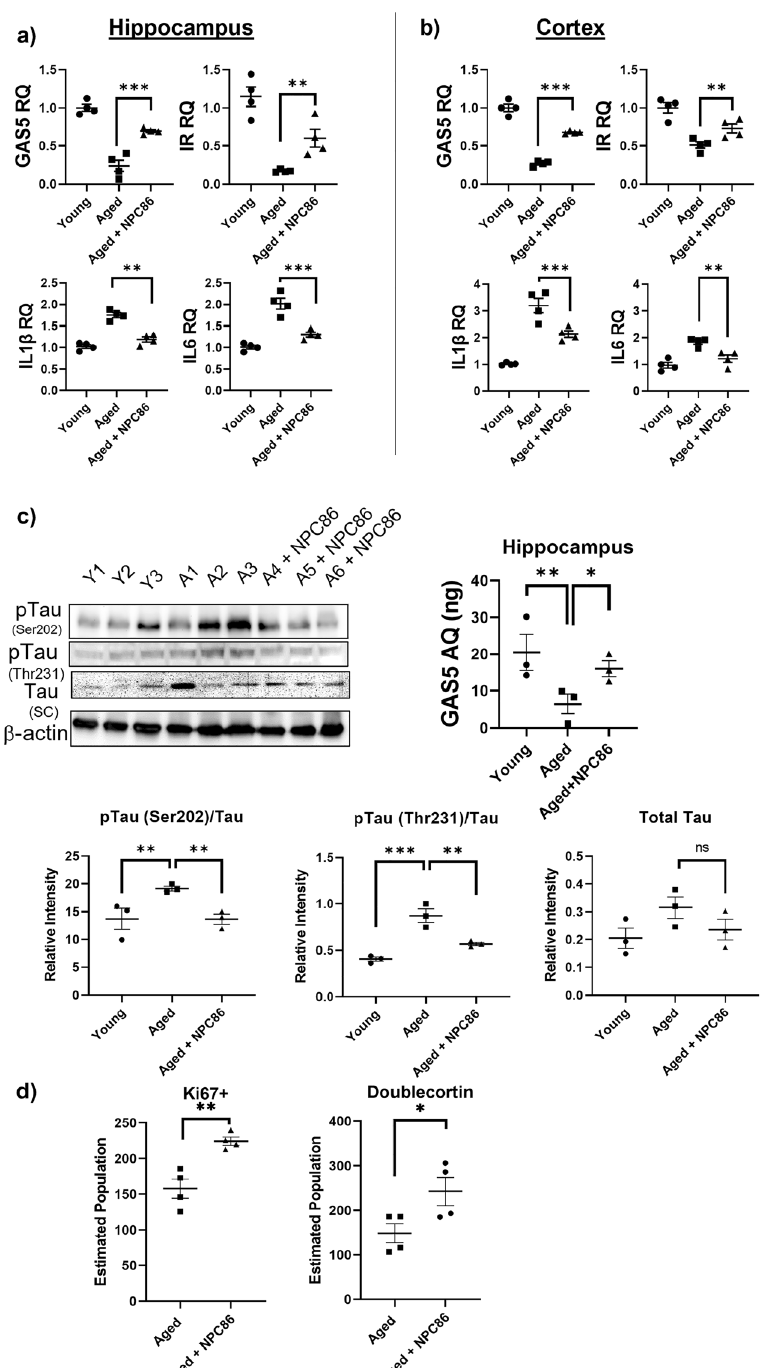
Figure 5. Administration of NPC86 to aged mice improves insulin signaling and decreases inflammation in vivo. 100 nM NP-C86 was administered intranasally to aged (20 months) C57BL/6J mice on alternate days (total 5 treatments). RNA was isolated on day 12 from ( a ) hippocampus and ( b ) cortex followed by qPCR analysis using primers for GAS5, insulin receptor, IL1β and IL6 and normalized to β-actin levels (n = 4). Relative quantification (RQ) was determined using young mice as reference. Each sample was run in triplicate. Statistical analysis was performed by one-way ANOVA, **p < 0.01, ***p < 0.001 comparing aged vs aged + NPC86. c) Hippocampal tissue was homogenized, and western blot analysis was performed on lysates using antibodies for pTau and total Tau as indicated (n = 3). Absolute quantification (AQ, ng) for GAS5 levels in hippocampal tissue of these mice. Densitometric analysis on the western blots was performed and pTau levels were normalized to total Tau. Statistical analysis was performed by one-way ANOVA, **p < 0.01, ***p < 0.001. d) The subgranular zone of the dentate gyrus was stained for Ki67 and doublecortin. Estimated population of Ki67 + and doublecortin in aged mice compared to aged + NPC86 was determined using the Stereo Investigator software (MicroBrightField, n = 4). Statistical analysis was performed by one-way ANOVA, **p < 0.01, *p <